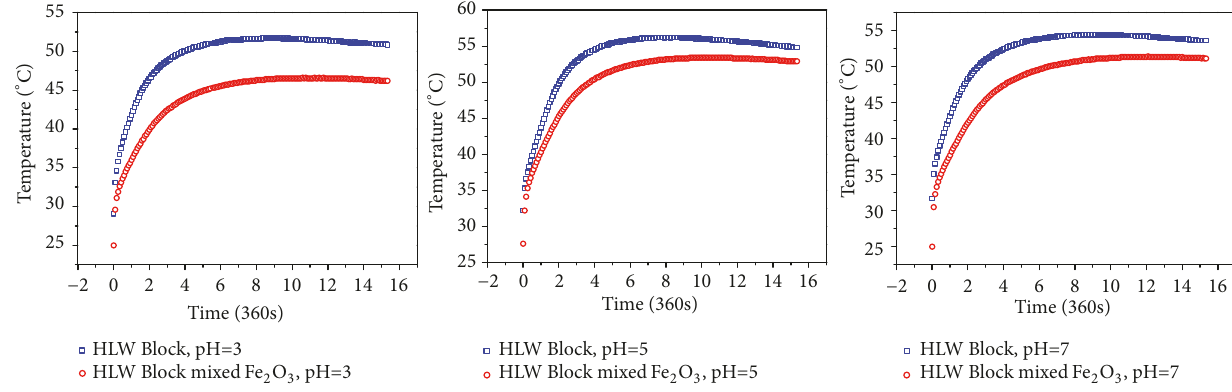
HLW Block, pH=5 HLW Block mixed ＆？ 2 ／ 3 , pH=5 Figure 4: Adiabatic temperature curve (Fe 2 O 3 dosage=9%).